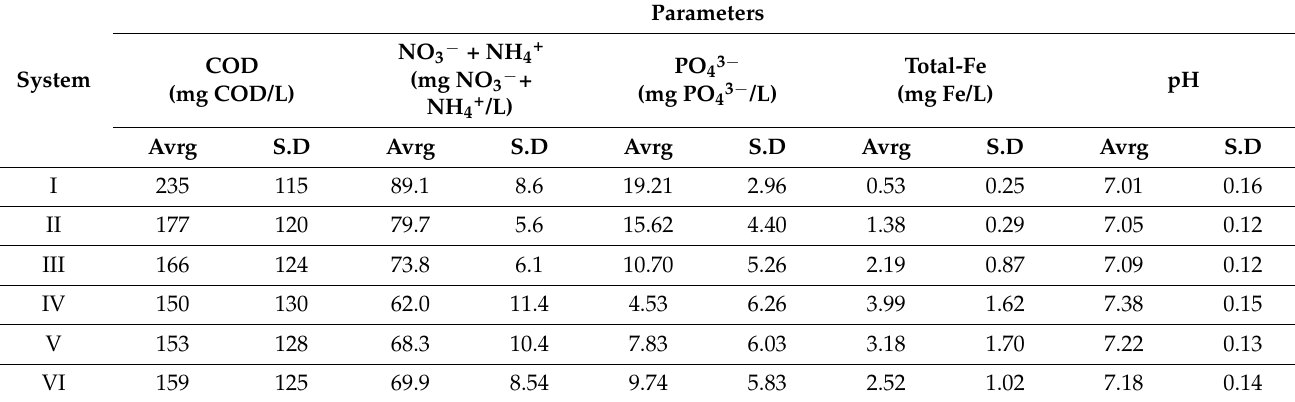
Table 3. Residual pollutants concentration in the systems. Experiments were operated at 37 ± 0.5 ◦ C for 76 days. Avrg stands for average, and S.D for standard